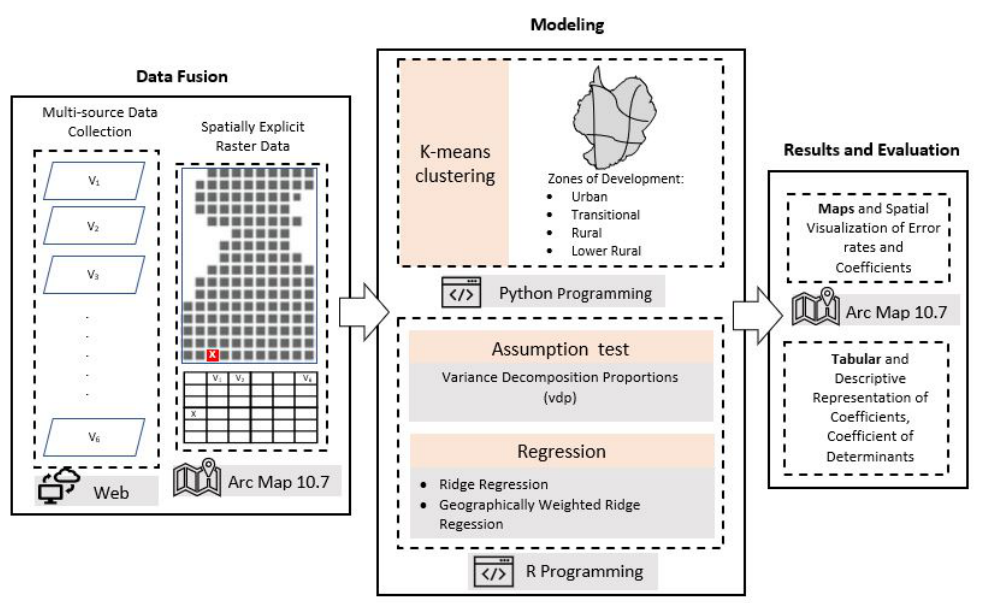
Figure 2. Methodology of the study; The variables comprise of a combination of place specific variables, (i.e., distance to energy extraction sites), socio-economic variables, distance to other forms of land development, and distance to Metropolitan Statistical